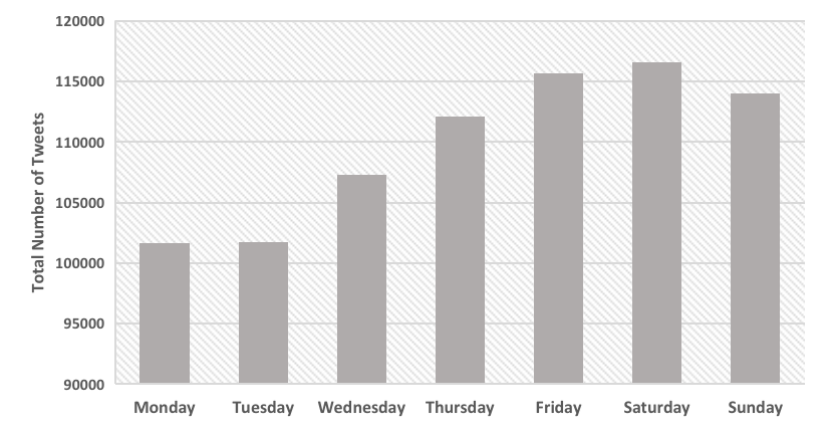
Figure 4. Total number of tweets posted per day of